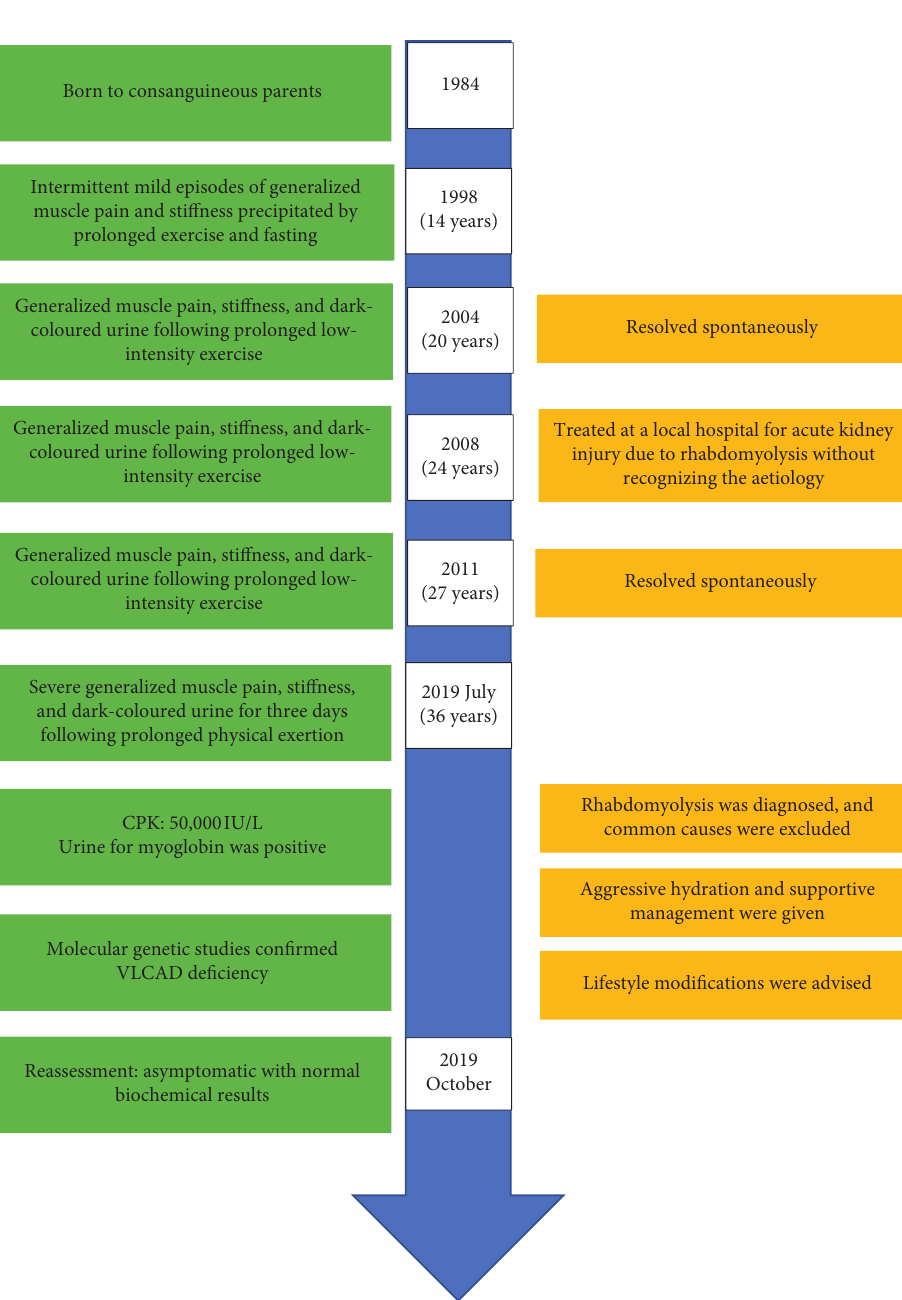
Figure 2: Timeline of events. Important events of the patient are shown in a